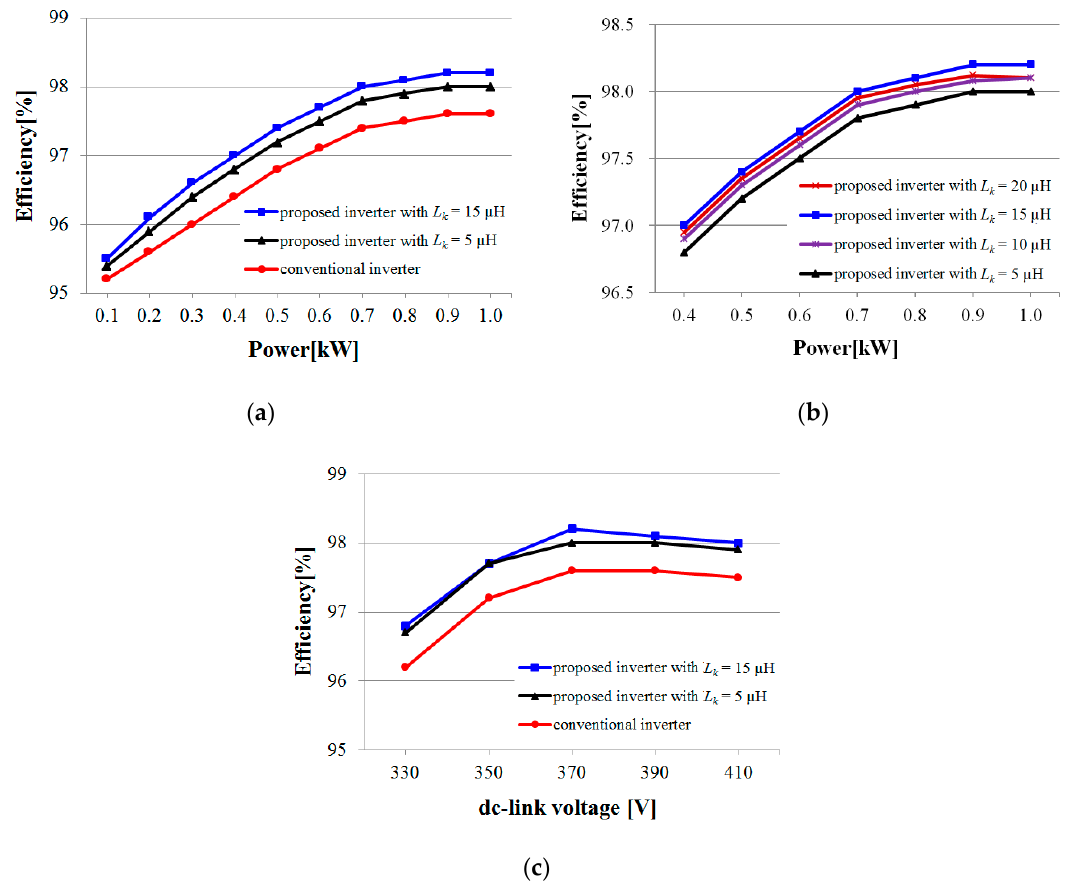
Figure 15. Measured power e ffi ciencies of the inverters: ( a ) for di ff erent output power levels when V dc is 370 V, and e a , e b , and e c are 127 V rms ; ( b ) for di ff erent leakage inductances when V dc is 370 V, and e a , e b , and e c are 127 V rms ; ( c ) for di ff erent dc-link voltage levels at the rated power.